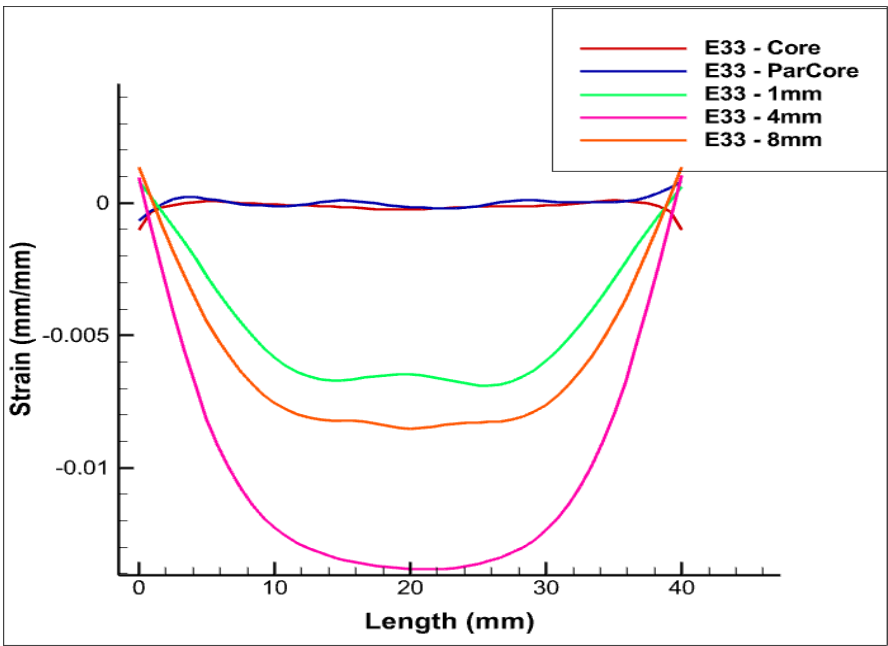
Figure 8. E zz Ezz for various positionings of FOS in the case of Pure Bending Test Case, along z